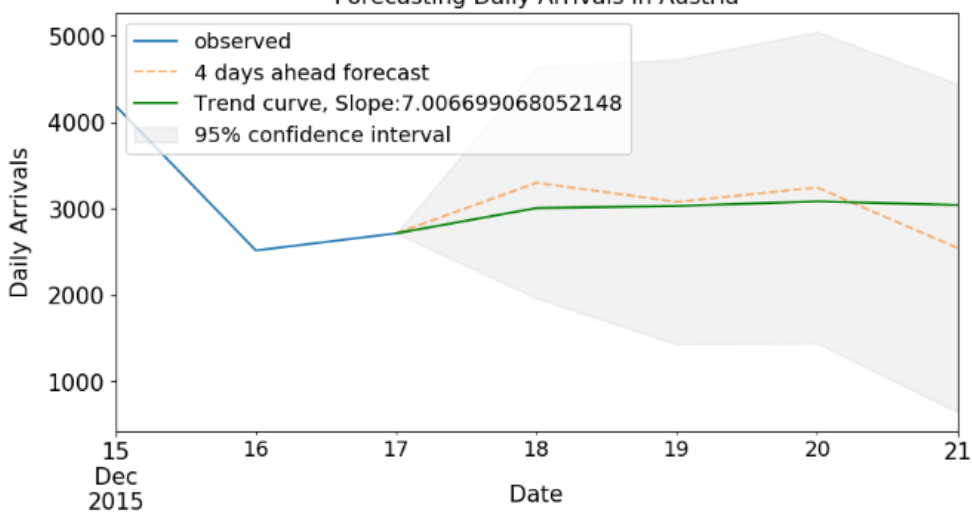
Figure 21. Forecasting daily arrivals in Austria, with confidence intervals and trend slope.